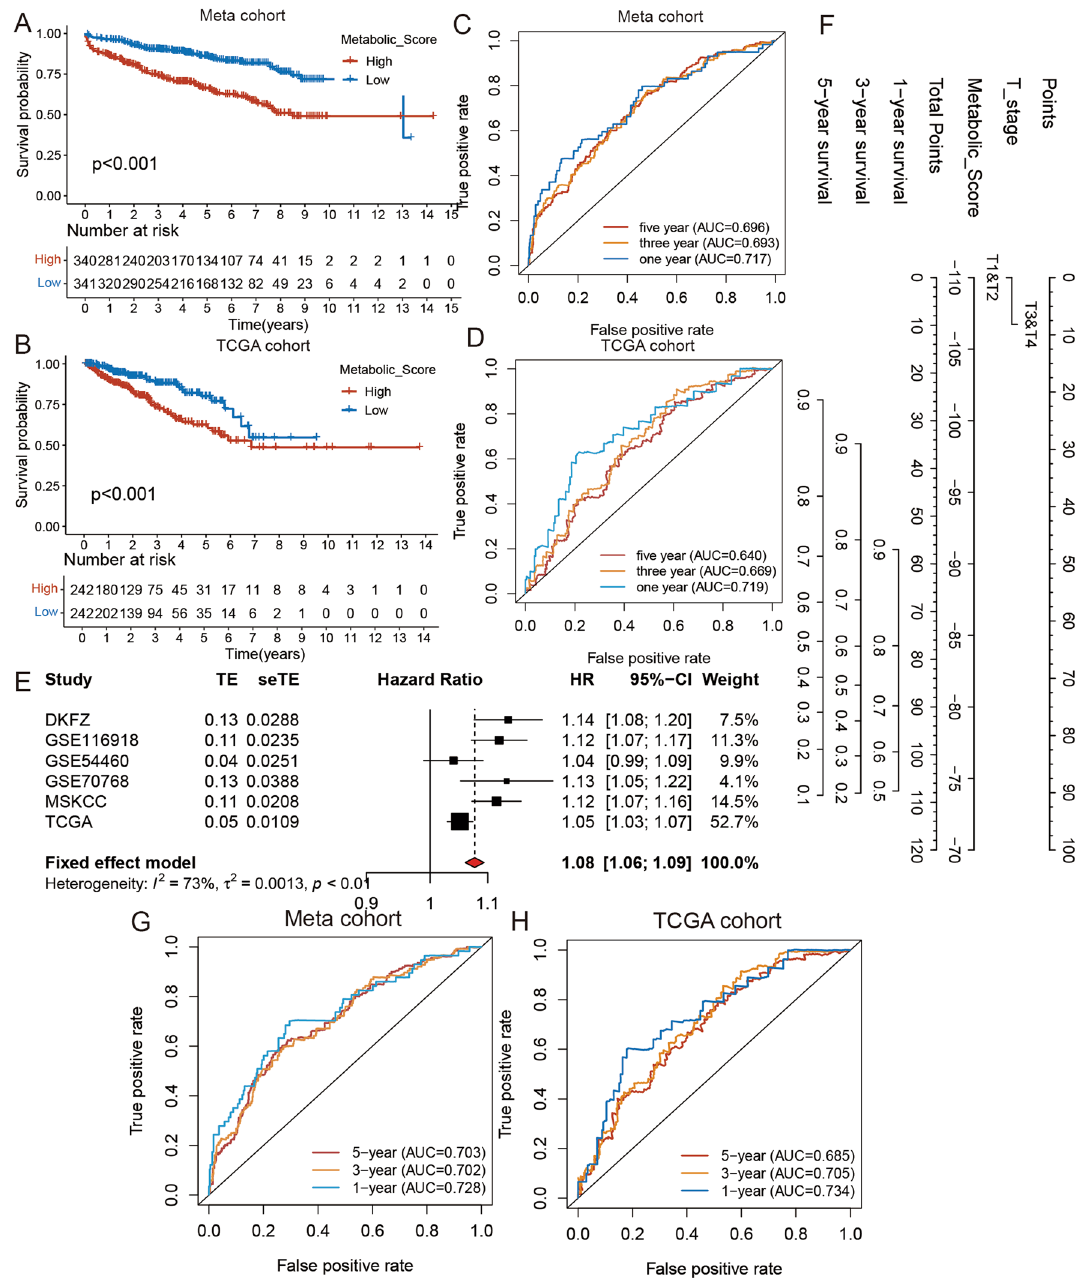
Figure 4. The prognostic value of metabolic score. ( A ) Kaplan–Meier curves for low and high metabolic score groups in meta cohort. Log-rank test, p < 0.001. ( B ) Kaplan–Meier curves for low and high metabolic score groups in TCGA cohort. Log-rank test, p < 0.001. ( C ) The ROC analysis of metabolic score in meta cohort. AUC = 0.717, 0.693, and 0.696 at 1, 3, and 5 year. ( D ) The ROC analysis of metabolic score in TCGA cohort. AUC = 0.719, 0.669, and 0.640 at 1, 3, and 5 year. ( E ) The meta-analysis of the HR of metabolic score in six cohort. ( F ) The nomogram based on metabolic score and clinical variates. ( G ) The ROC analysis of nomogram in meta (training) cohort. AUC = 0.728, 0.702, and 0.703 at 1, 3, and 5 year. ( H ) The ROC analysis of nomogram in TCGA (validation) cohort. AUC = 0.734, 0.705, and 0.685 at 1, 3, and 5